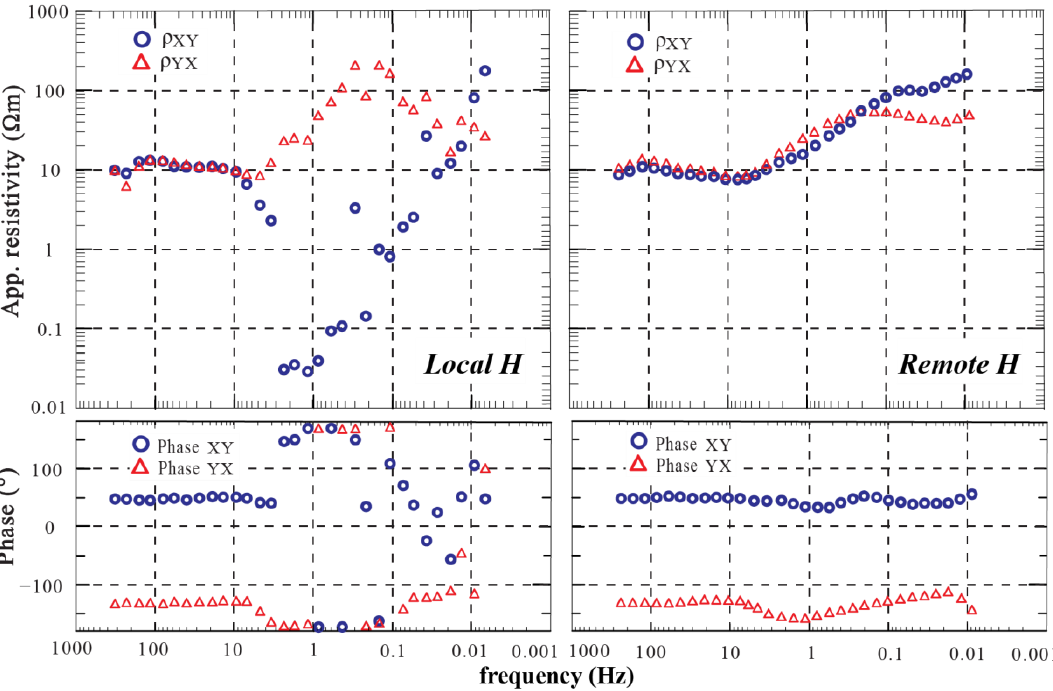
Figure 3. Sounding curves of the MT station L3-6. Left and right panels: processed with local and remote referencing of magnetic field components, respectively.